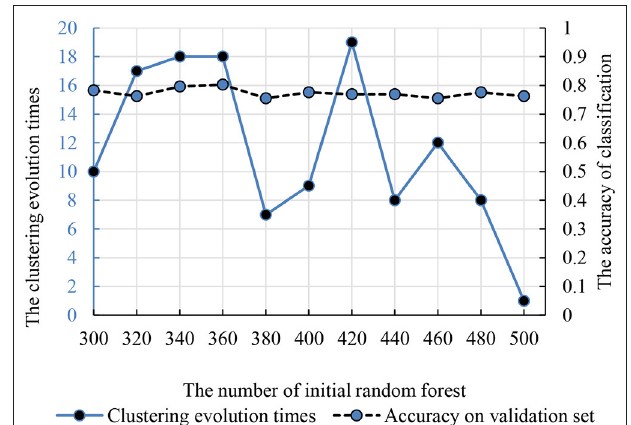
FIGURE 5 | The relationship between the clustering evolution times and initial random forest number. The dotted line is the classification accuracy. The solid line is the times of clustering evolution times based on the decision trees.